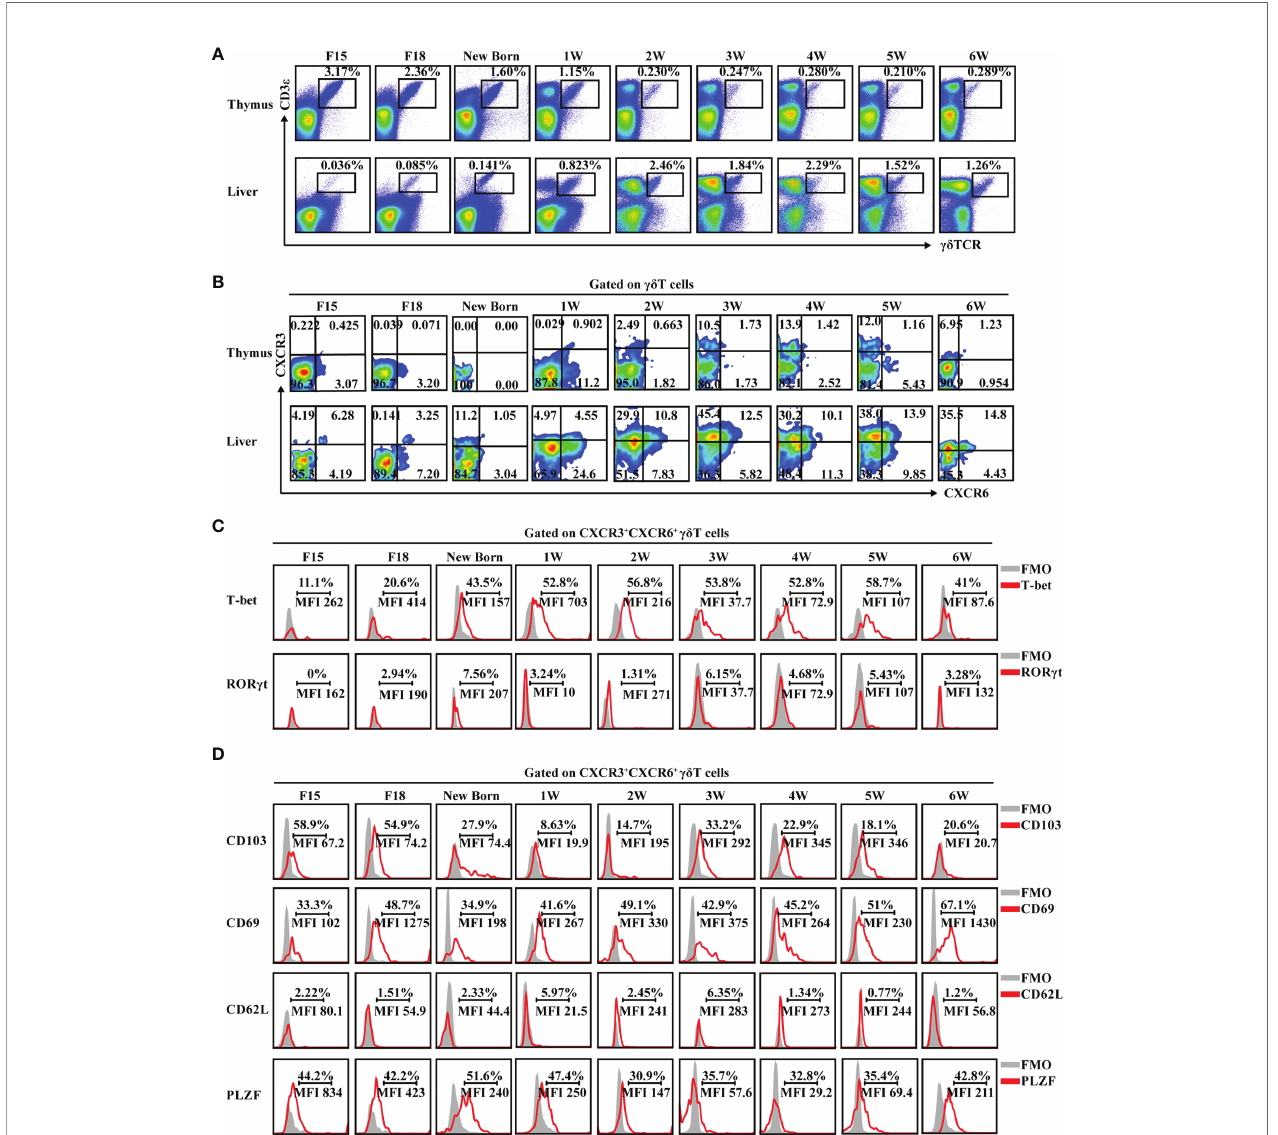
FIGURE 4 | CXCR3 + CXCR6 + gd T cells exist in liver and express tissue-resident markers from embryo to adulthood. (A) FACS analysis of gd T cells in thymus (top) and liver (bottom) at different developmental stages of C57BL/6J mice. (B) FACS analysis of CXCR3 + CXCR6 + gd T cells in the thymus and liver at the different developmental stages of C57BL/6J mice. (C, D) FACS analysis of T-bet and ROR g t (C) and CD103, CD69, CD62L, and PLZF expression (D) in hepatic CXCR3 + CXCR6 + gd T cells at the indicated ages over